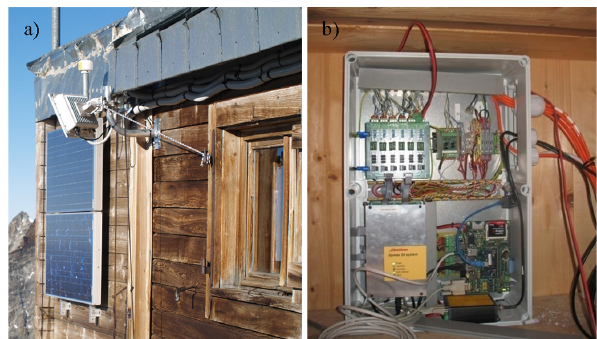
Fig. 3. (a) The solar panels, the GPS and the aerial radio installed outside the Carrel hut; (b) the acquisition system installed inside the hut (photo by Signori and Bani, 2010). Fig. 4. Calibration tests of the MS monitoring system: (a) the ham- mering of the rock surface; (b) the topographic survey of the